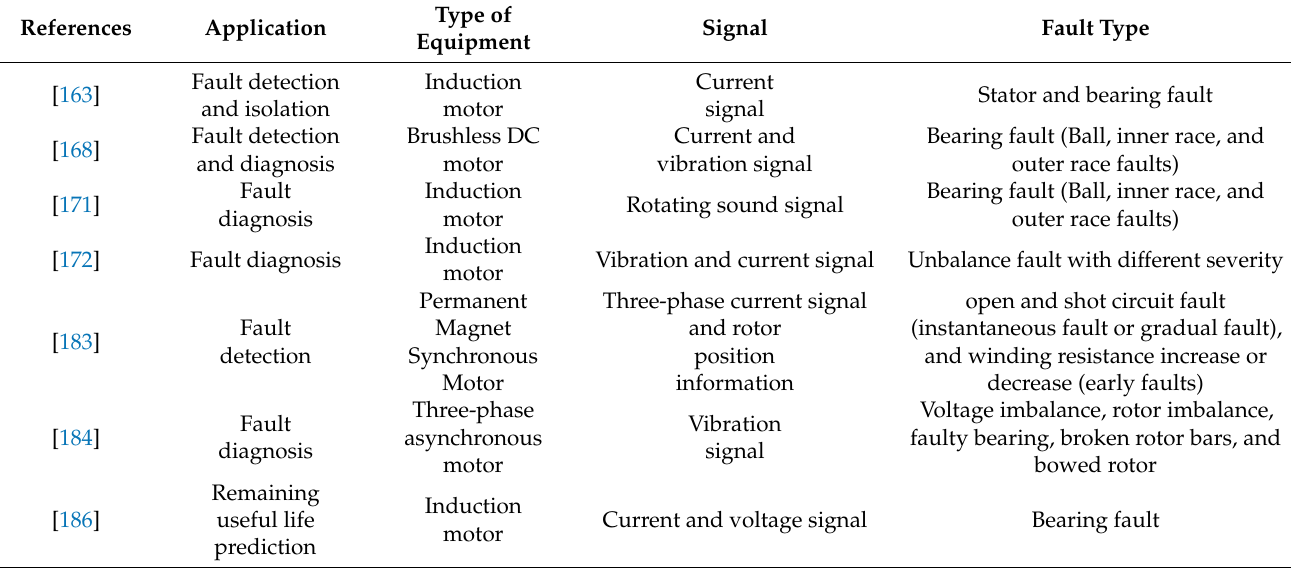
Table 21. Motor condition monitoring using recurrent neural network.